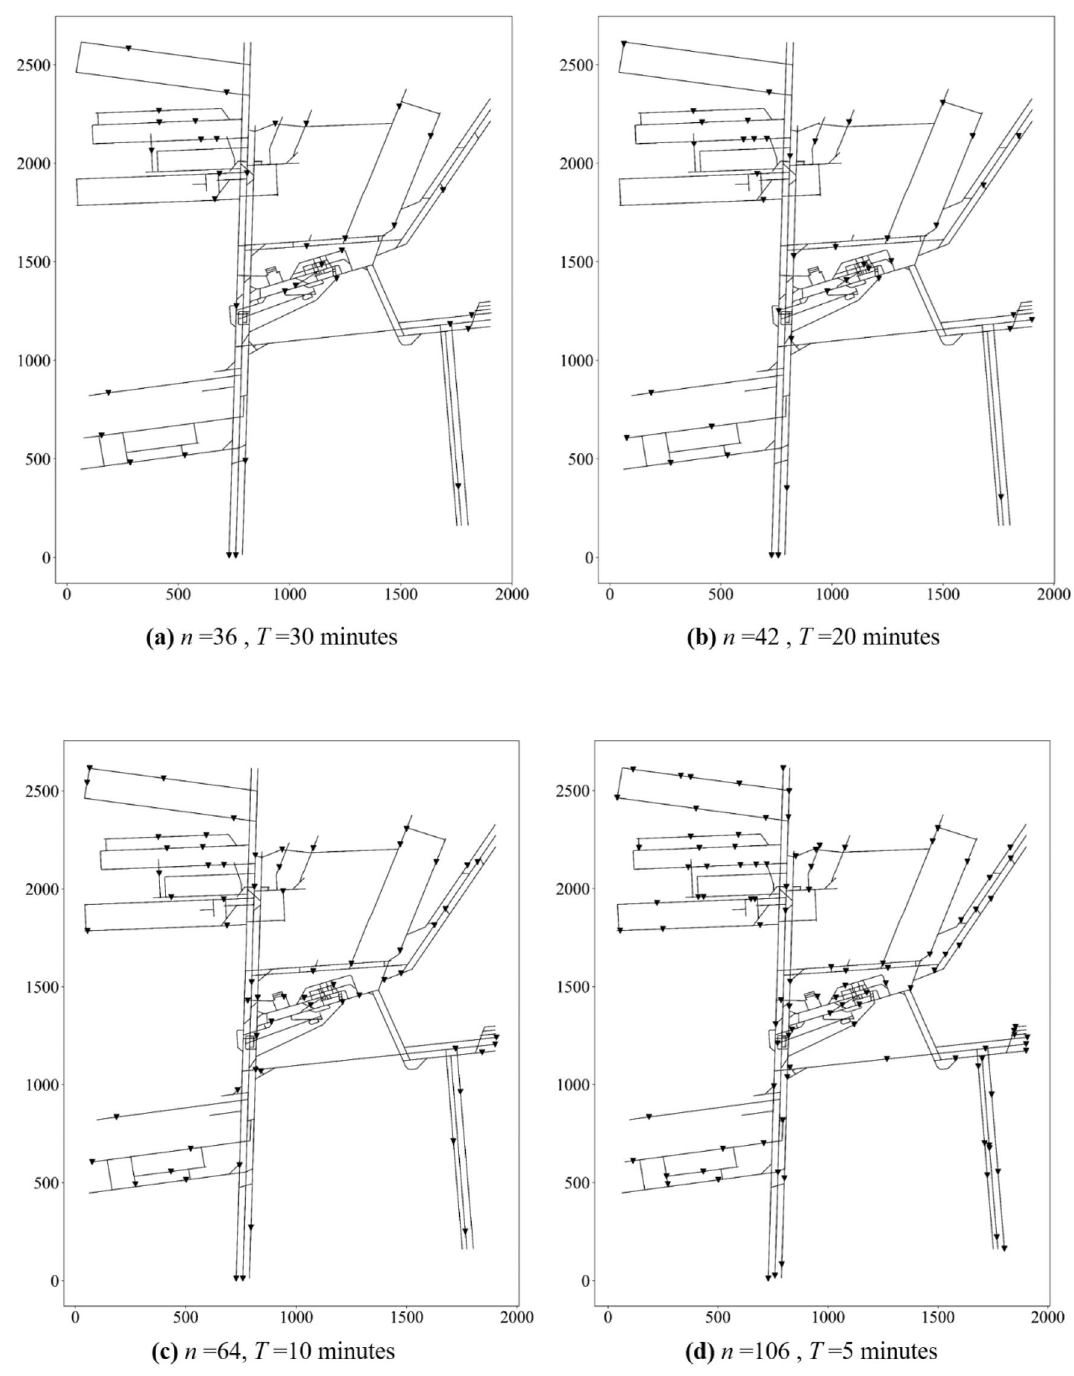
Figure 11. The number ( n ) and locations of water level sensors in different given time